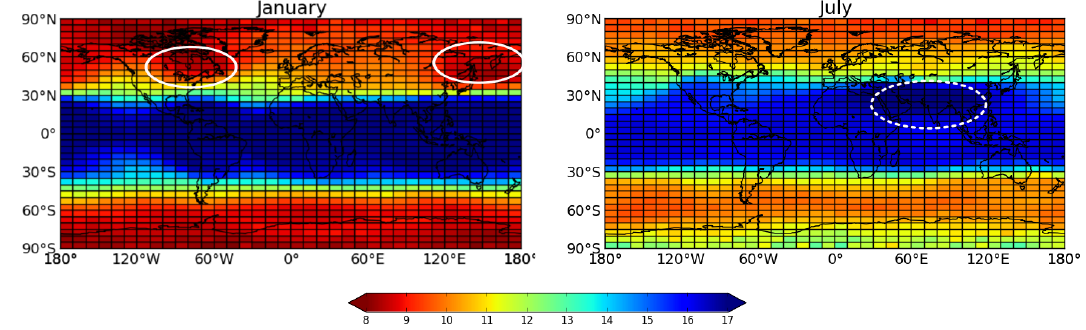
Figure 6. Mean altitude (km) of first tropopauses for January and July from 2007 to 2013. White circles denote areas of exceptionally low (solid) and high (dashed) tropopauses within the respective latitude